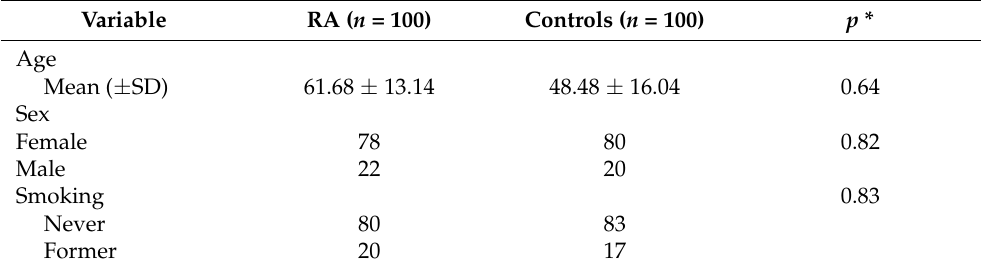
Table 1. Distributions of demographic variables between 100 RA cases and 100